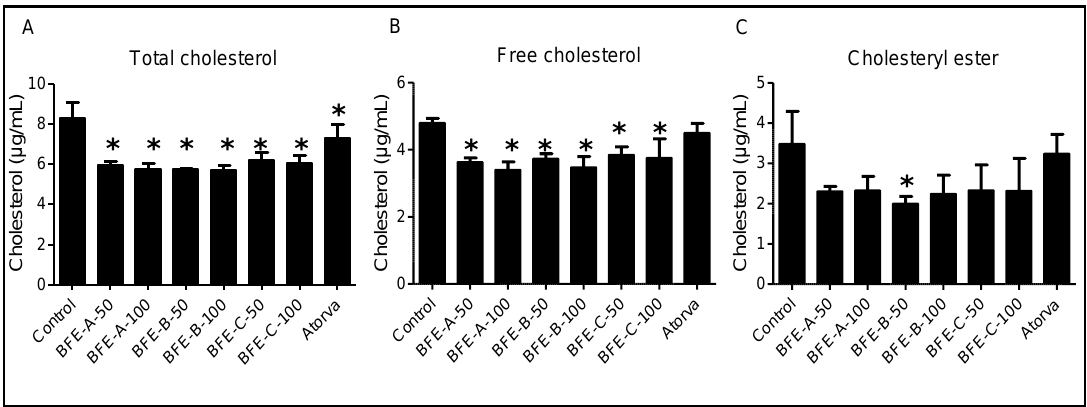
Figure 2. The total cholesterol, free cholesterol, and cholesterol ester in HepG2 cells treated with 50 and 100 μg/mL BFE. ( A ), total cholesterol; ( B ), free cholesterol; ( C ), cholesterol ester. Results are from four independent experiments and expressed as the mean ± SE. Significant differences between values were determined by the one-way ANOVA. *: p < 0.05 compared with control group. BFE-A-50, bergamot fruit extract A 50 μg/mL; BFE-A-100, bergamot fruit extract A 100 μg/mL; BFE-B-50, bergamot fruit extract B 50 μg/mL; BFE-B-100, bergamot fruit extract B 100 μg/mL; BFE-C-50, bergamot fruit extract C 50 μg/mL; BFE-C-100, bergamot fruit extract C 100 μg/mL; Atorva, atorvastatin.